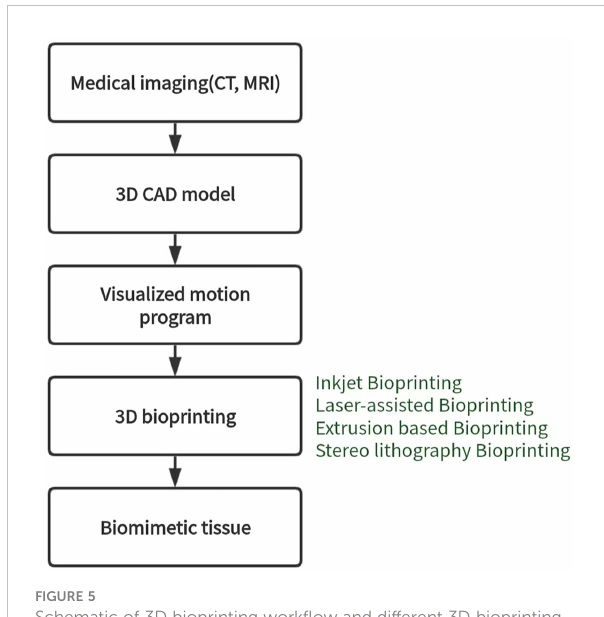
FIGURE 5 Schematic of 3D bioprinting work fl ow and different 3D bioprinting